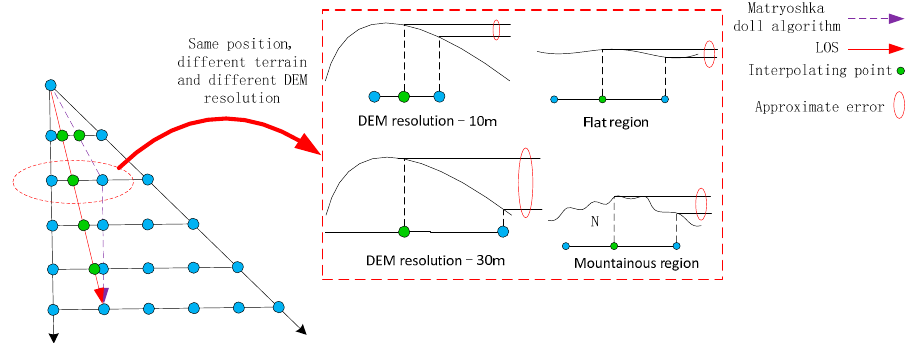
Figure 23. Demonstrating the difference between the proposed algorithm and the traditional method. The proposed algorithm uses the data of the DEM (denoted by blue dots) to approximate the interpolated data (denoted by red dots) on the LOS. The approximation varies with different terrain and resolution of